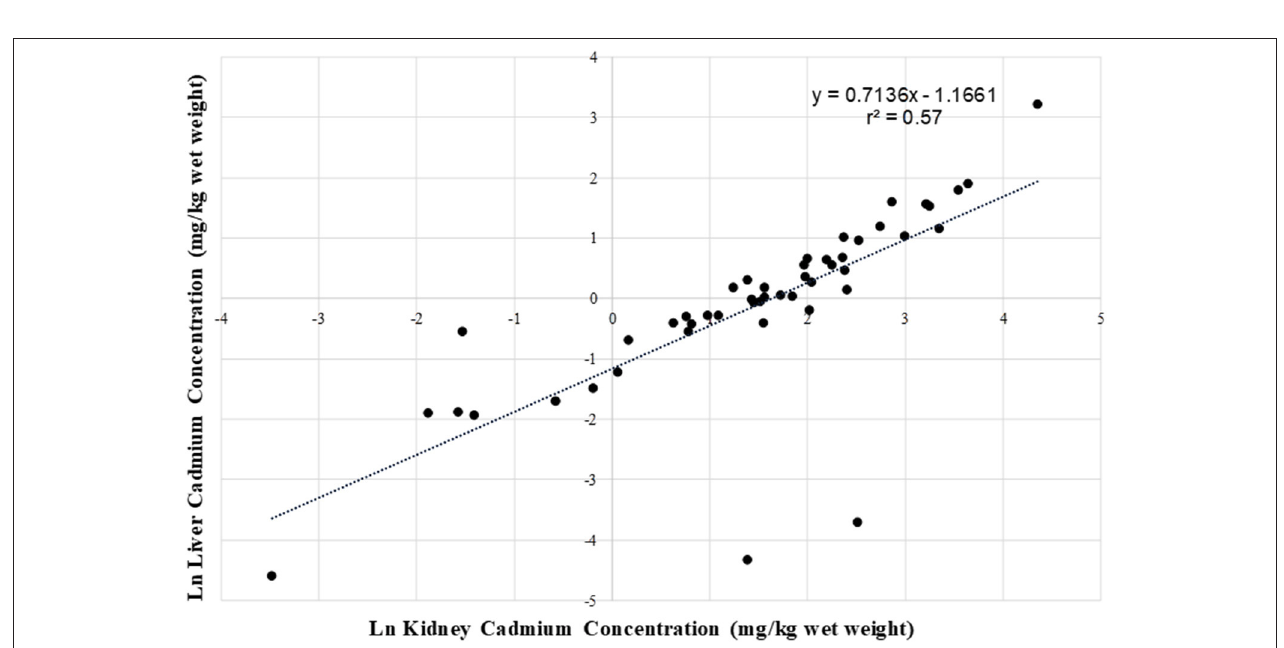
FIGURE 7 | Comparison of natural log transformed cadmium concentrations from pooled dataset.